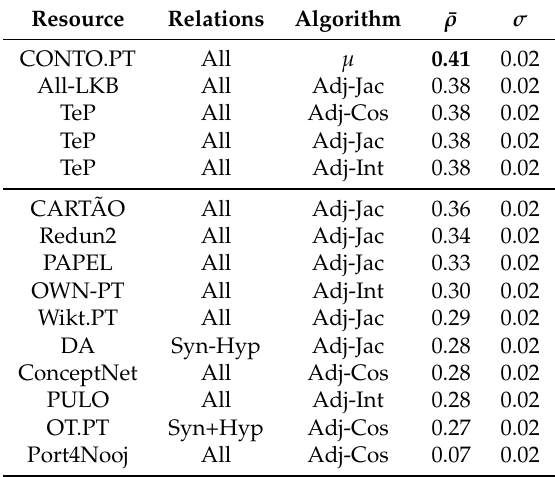
Table 10. Performance overview of LKBs in the RareWords test.